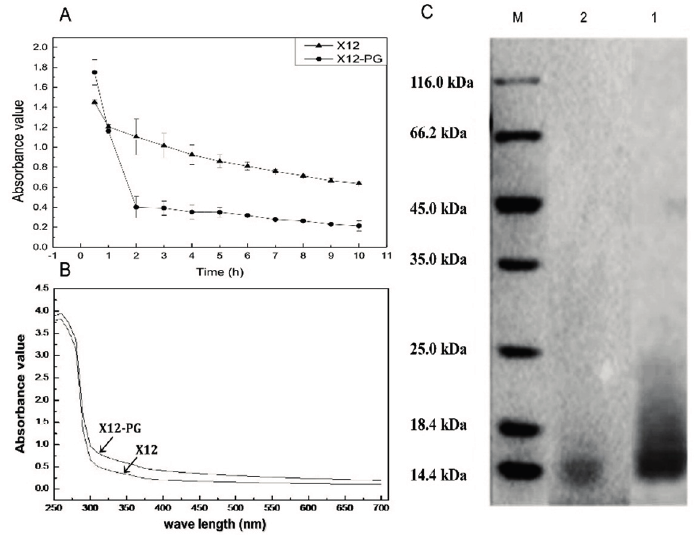
Figure 2. Quantitative and qualitative analysis of X12-PG. ( A ) The degradation models of X12-PG and X12 when exposed to lysozyme. A 450 nm of X12-PG declined faster than that of X12; ( B ) The UV-visible scanning spectrum of X12-PG and peptidoglycan standard. The standards and samples were scanned between 190 and 700 nm in a UV/VIS spectrophotometer; and ( C ) The molecular weight (kDa) of X12-PG quantified by SDS-PAGE. The gels were stained with Coomassie Brilliant Blue. The molecular weight was 14 kDa, corresponding to the peptidoglycan standard. Each graph represents the average of more than three